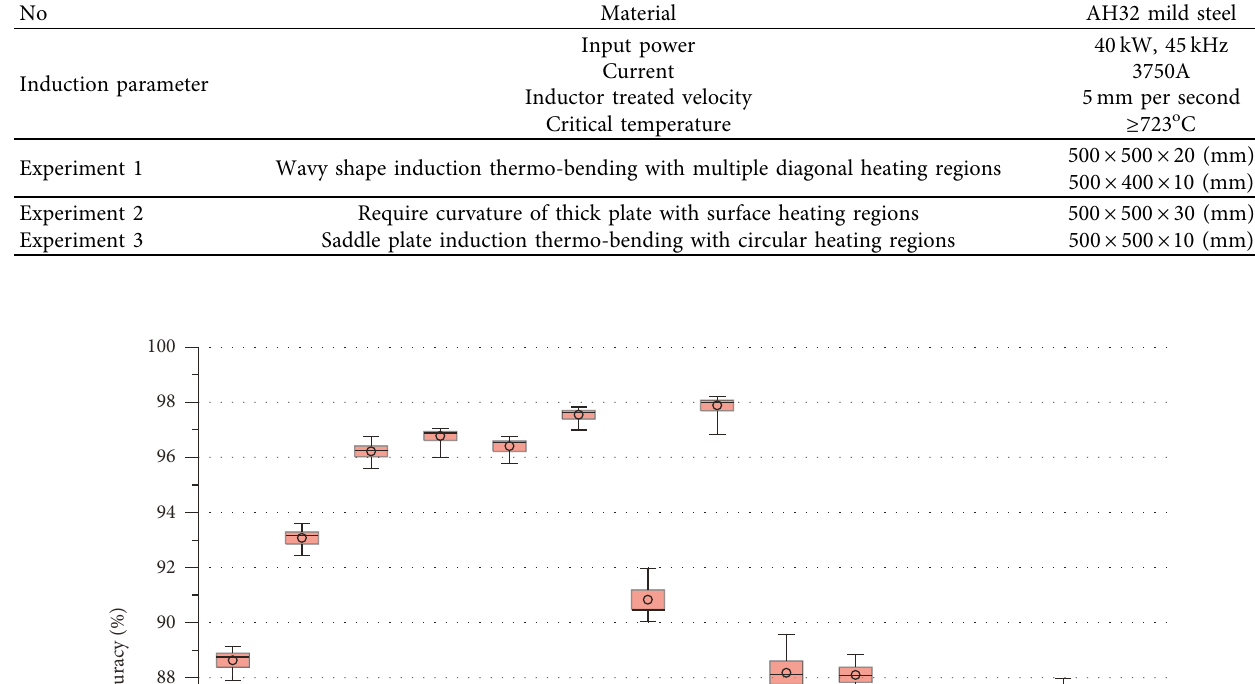
Table 1: Induction parameter for experiment and analysis and estimating form by ANN and experiment.